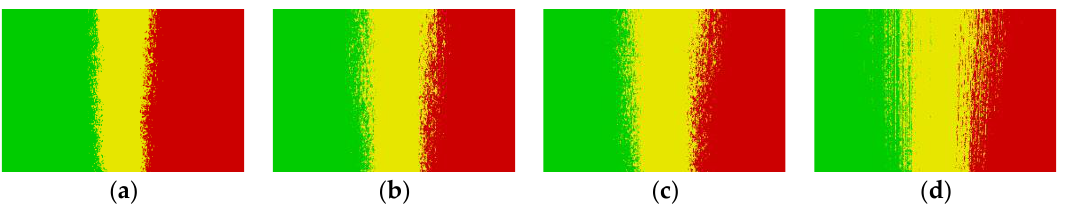
Figure 15. Segmentation results on four aliasing images whose roughness is 0.0392, 0.1690, 0.2964, 0.4261 μm , respectively. ( a ) 0.0392μm , ( b ) 0.1690μm , ( c ) 0.2964μm , ( d ) 0.4261 μm .